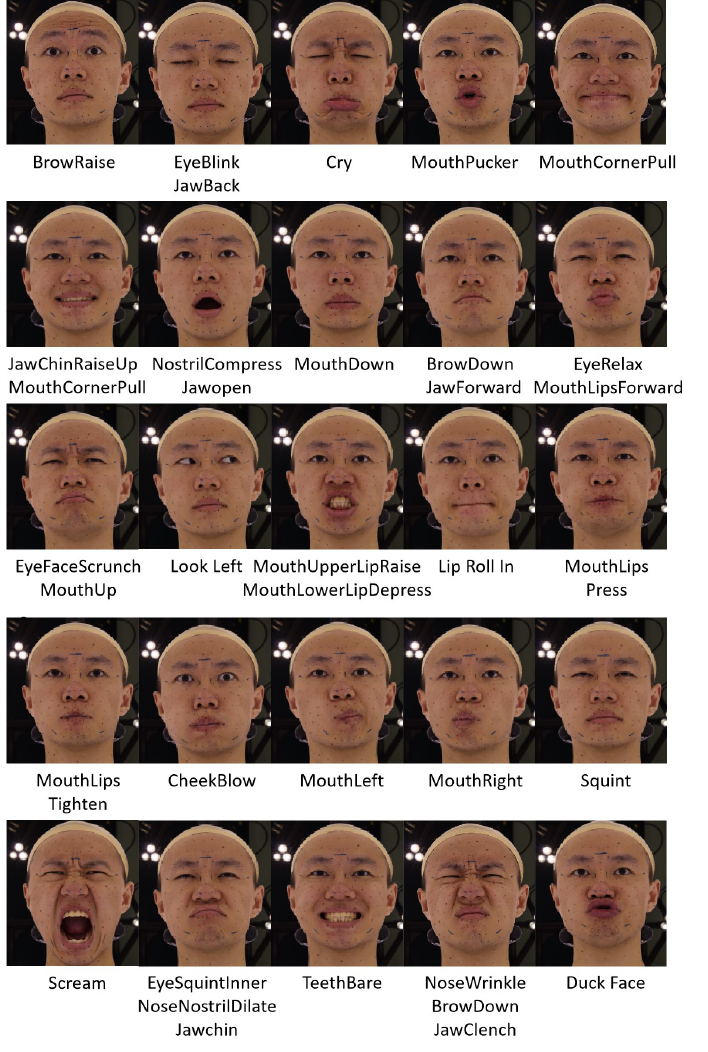
Figure 7. The 25 expressions